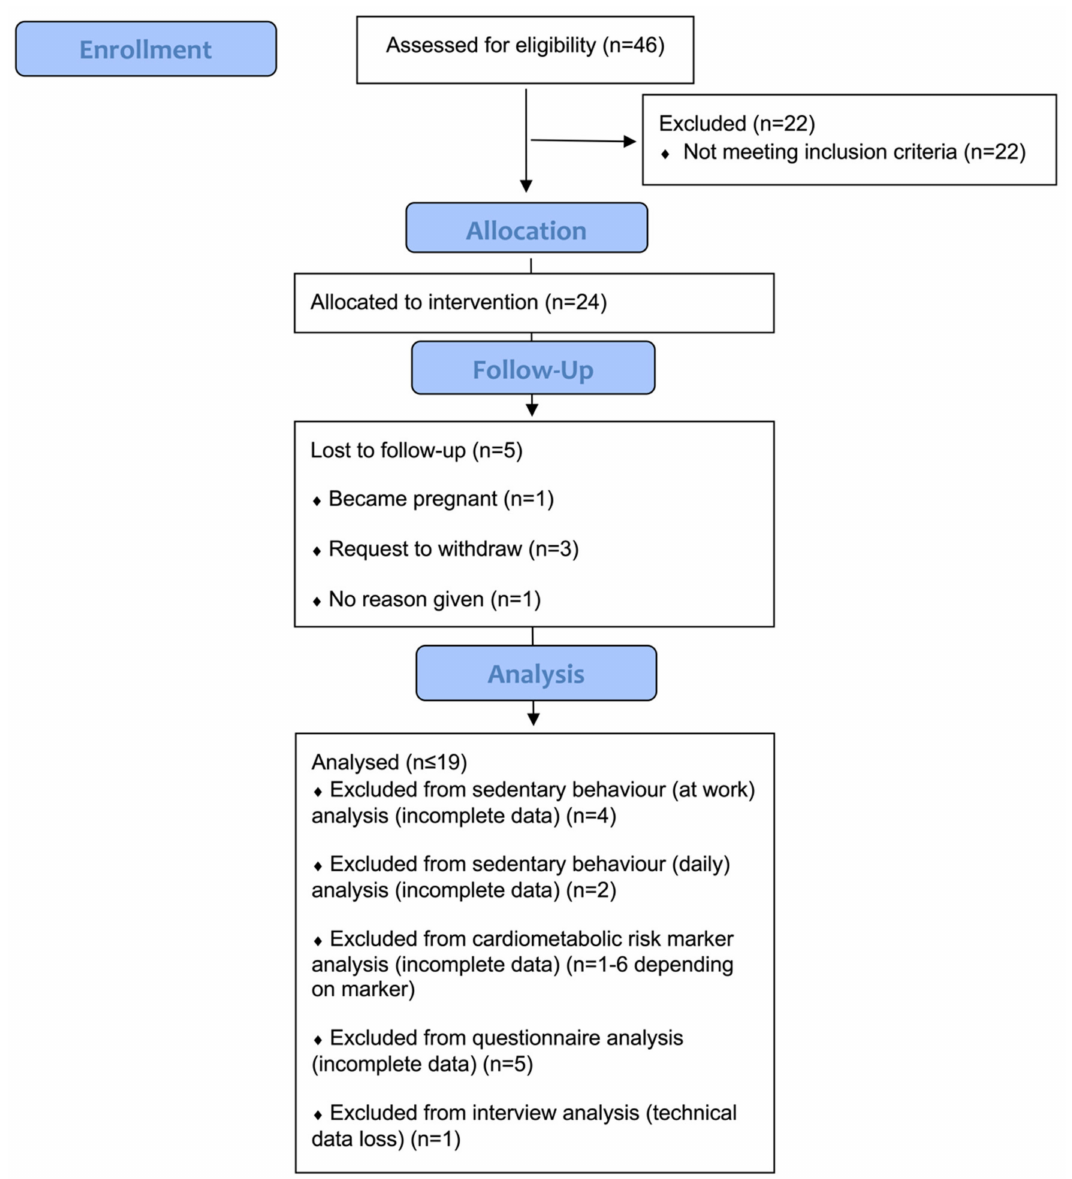
Figure 3. CONSORT diagram showing the flow of participants through the